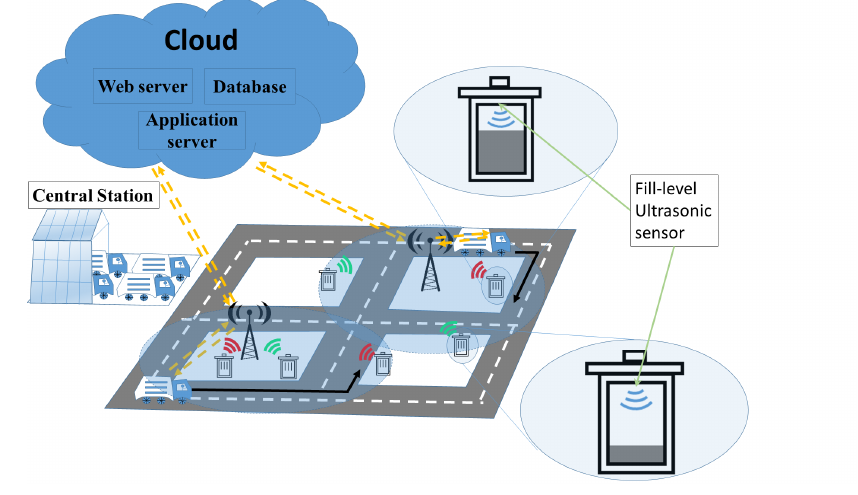
Figure 1. An overview of the system